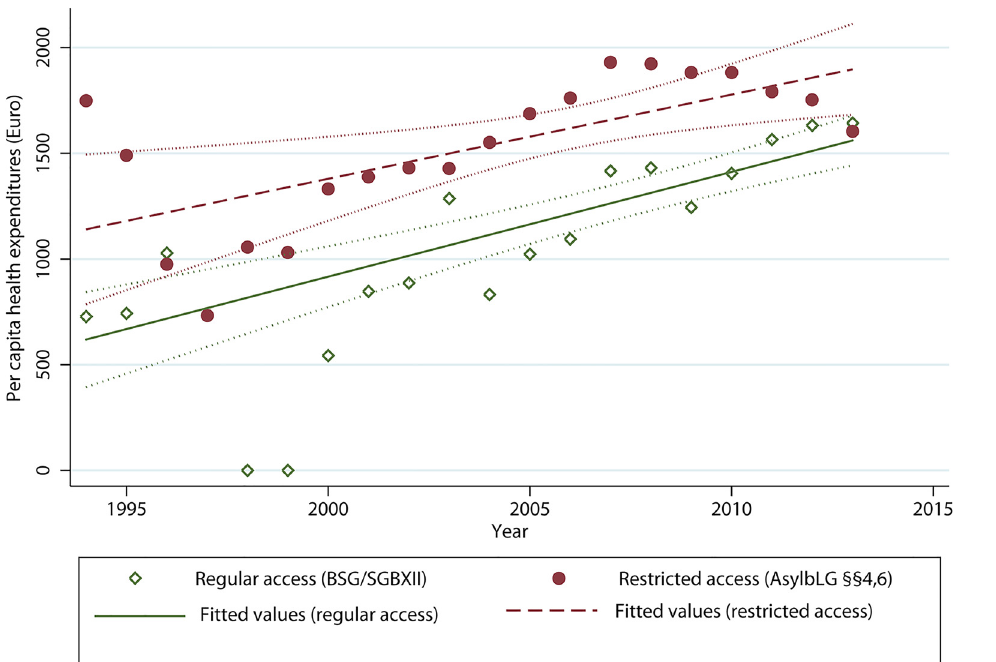
Fig 6. Scatter plot and fitted values of per capita health expenditures on asylum-seekers and refugees by entitlement on access to health care. Restricted access: refers to access to health care according to sections 4 and 6 of the Asylum-Seekers ’ Benefits Act (AsylbLG §§4,6). Regular access: refers to access to health care analogously to the general population according to the Federal Social Security Act (Bundessozialhilfegesetz, BSG) before 2005 and to Volume 12 of the Social Insurance Code ( Leistungen nach dem 5 . -9 . Kapitel SGB XII ) thereafter. Dotted lines below/above fitted values: constitute 95% confidence intervals, obtained from robust standard errors clustered by year. The observations in 1997 – 1999 were excluded from the analysis in predicting fitted values for the group with regular access because the denominator (on 31 Dec) was zero.